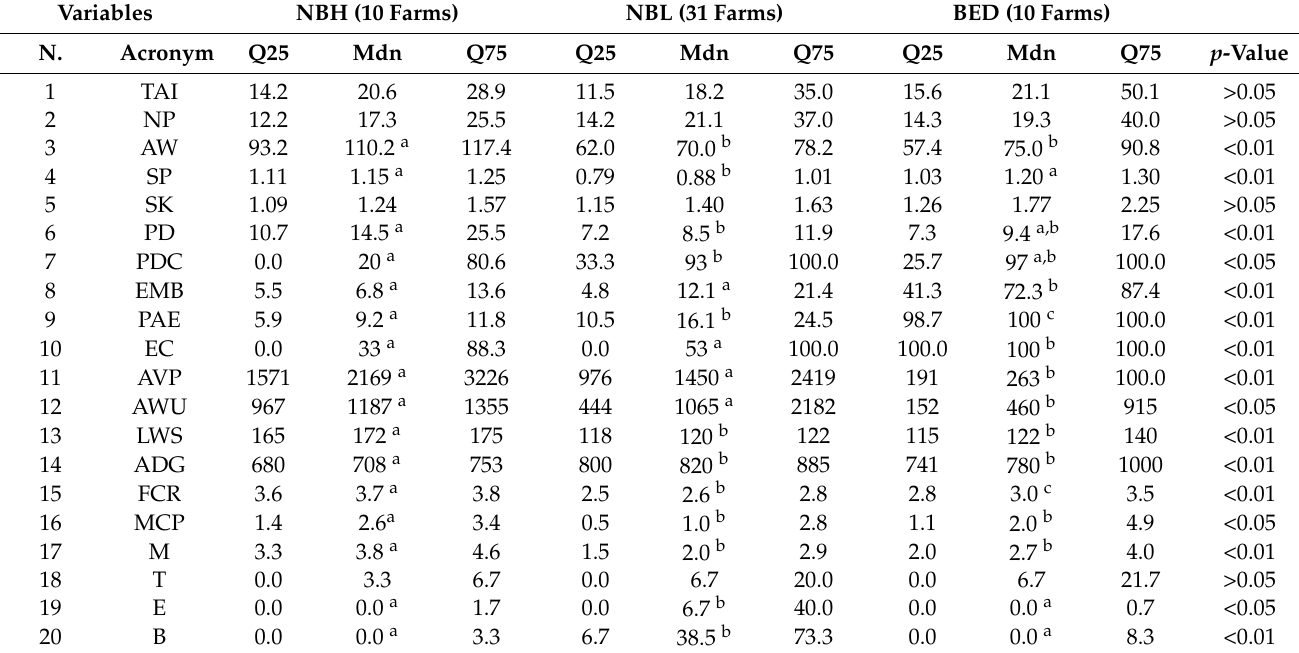
Table 3. Statistics for 20 continuous